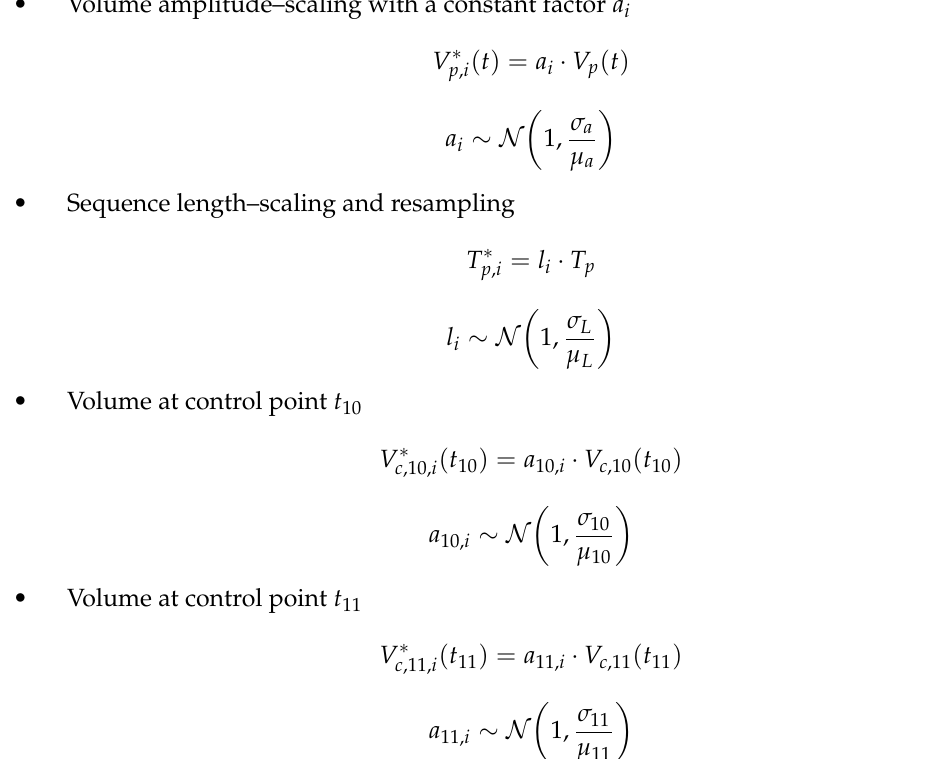
Figure 7. The four parameters take effect according to the following equations: